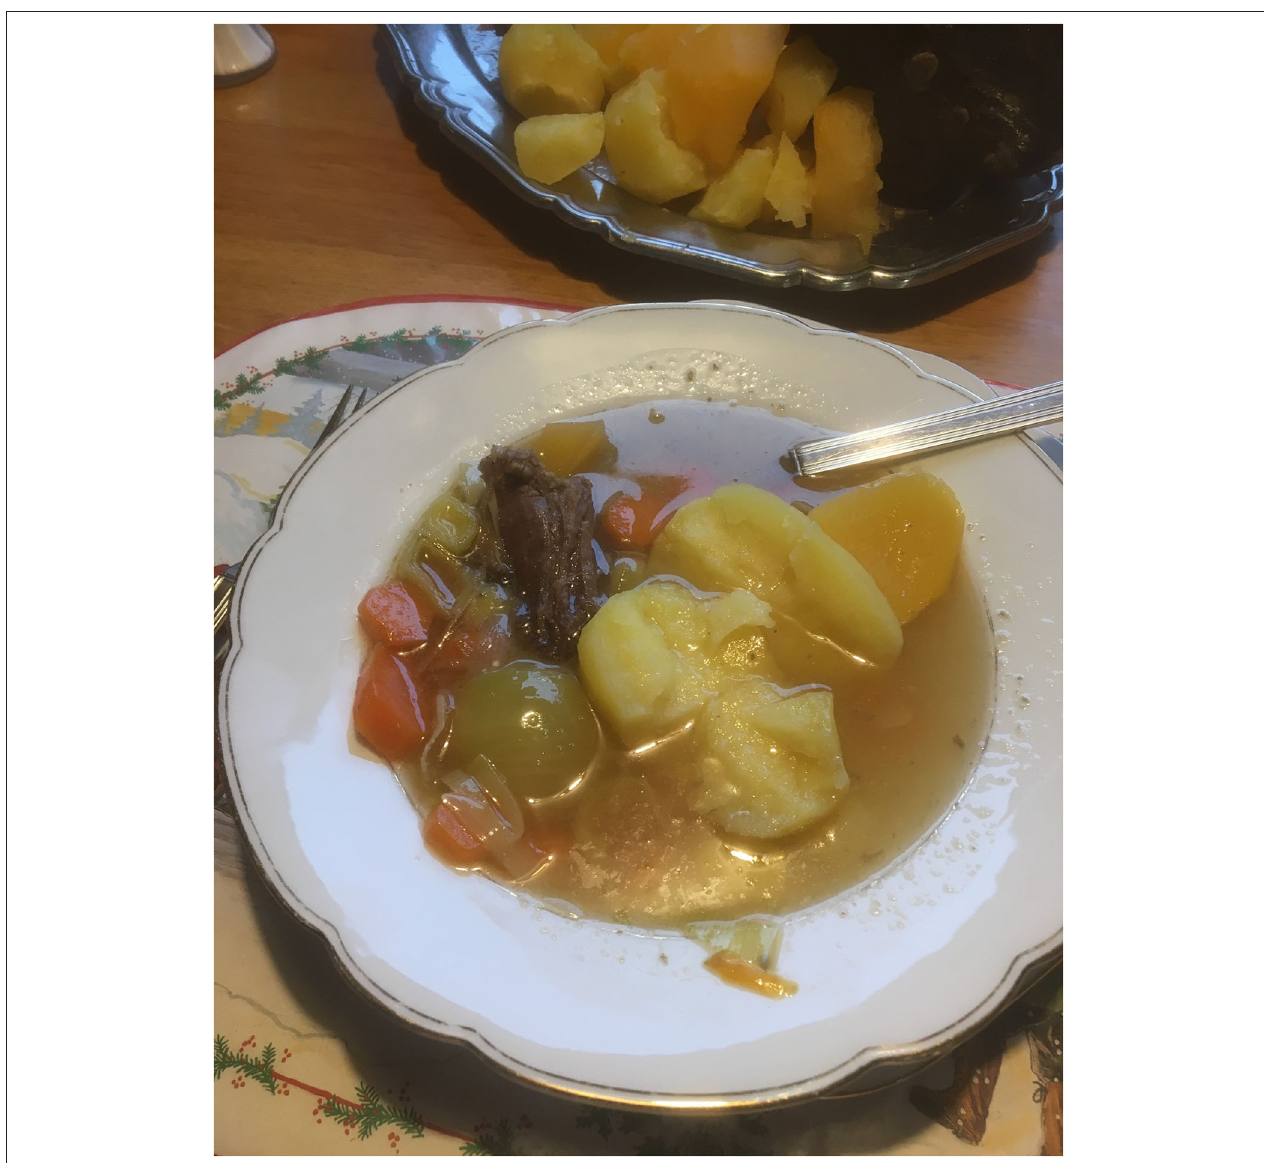
FIGURE 4 | Meat broth is a product made with fat from fermented mutton (ræst kjøt). It is used for soup, súpan, here served with pieces of ræst kjøt, potatoes, and leeks (Photo: Ingvar Svanberg, December